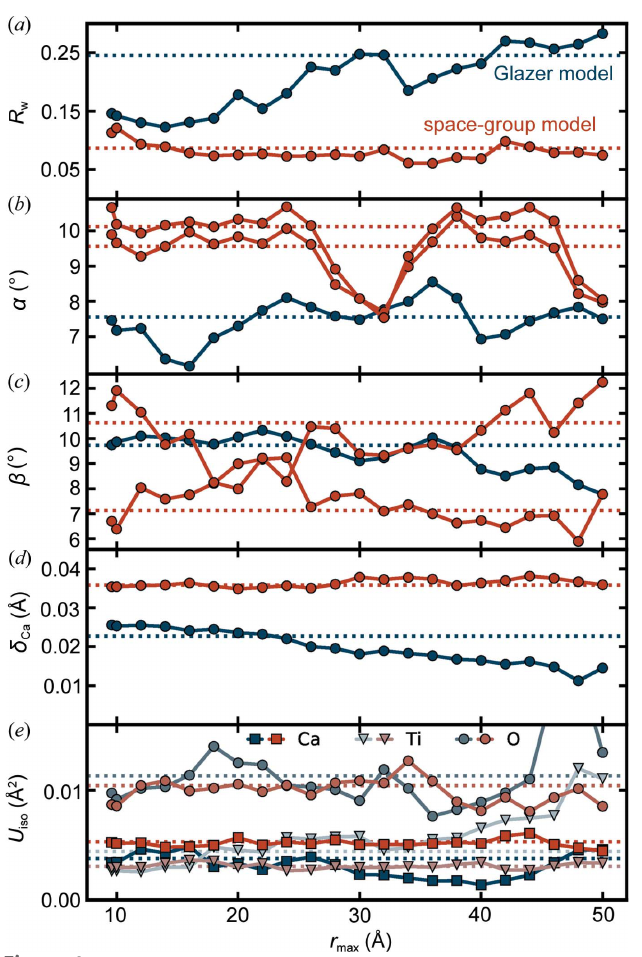
Figure 4 Comparison of the ( a ) fit residual R w , the octahedral tilt amplitudes ( b ) (cid:2) and ( c ) (cid:3) , ( d ) the total Ca displacements ( (cid:5) Ca ), and ( e ) the U iso values from boxcar fits with the space-group model and the Glazer model of CaTiO 3 at 200 K. The r range (or ‘the box’) was set to 8 A˚ and incrementally shifted to higher r values in steps of 2 A˚ . The labels on the x axis correspond to the highest value in the box, r max . The dotted lines represent the values obtained from a fit over the 1.6–50 A˚ range. We note that, for the space-group model, the tilt angles (cid:2) and (cid:3) differ depending on which octahedra were used to calculate them, and such are represented by two different